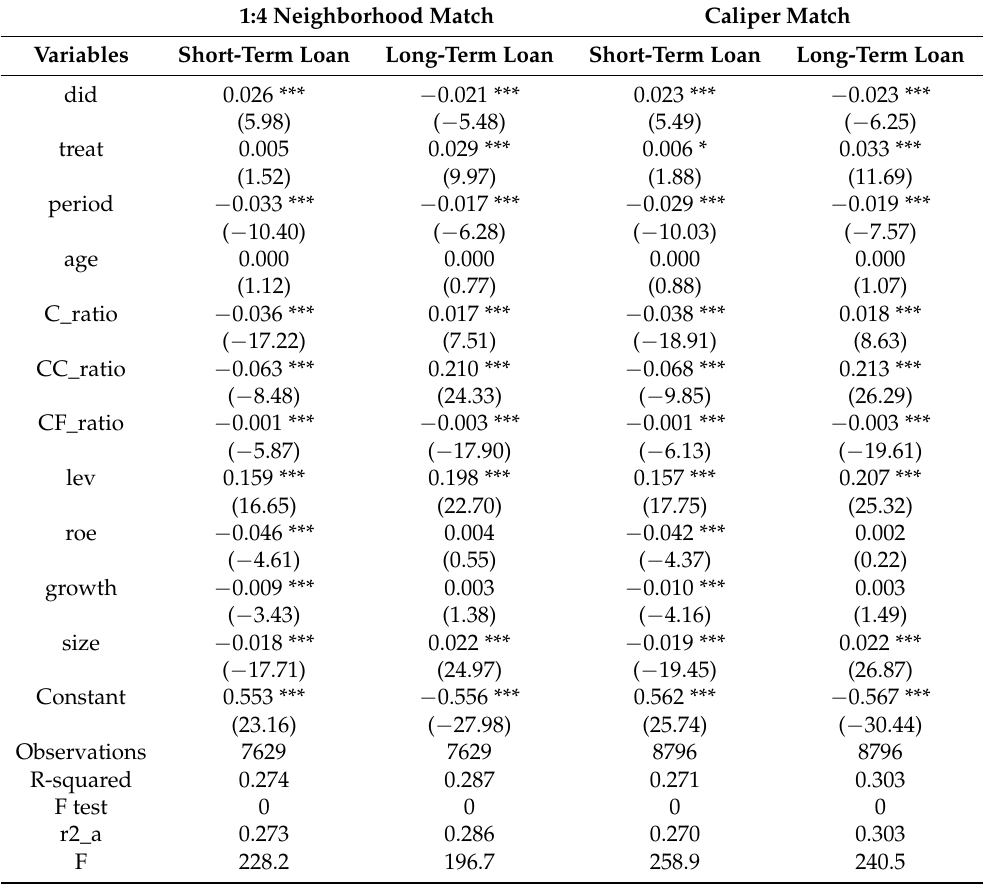
Table 7. Robustness test regression results after the replacement of matching